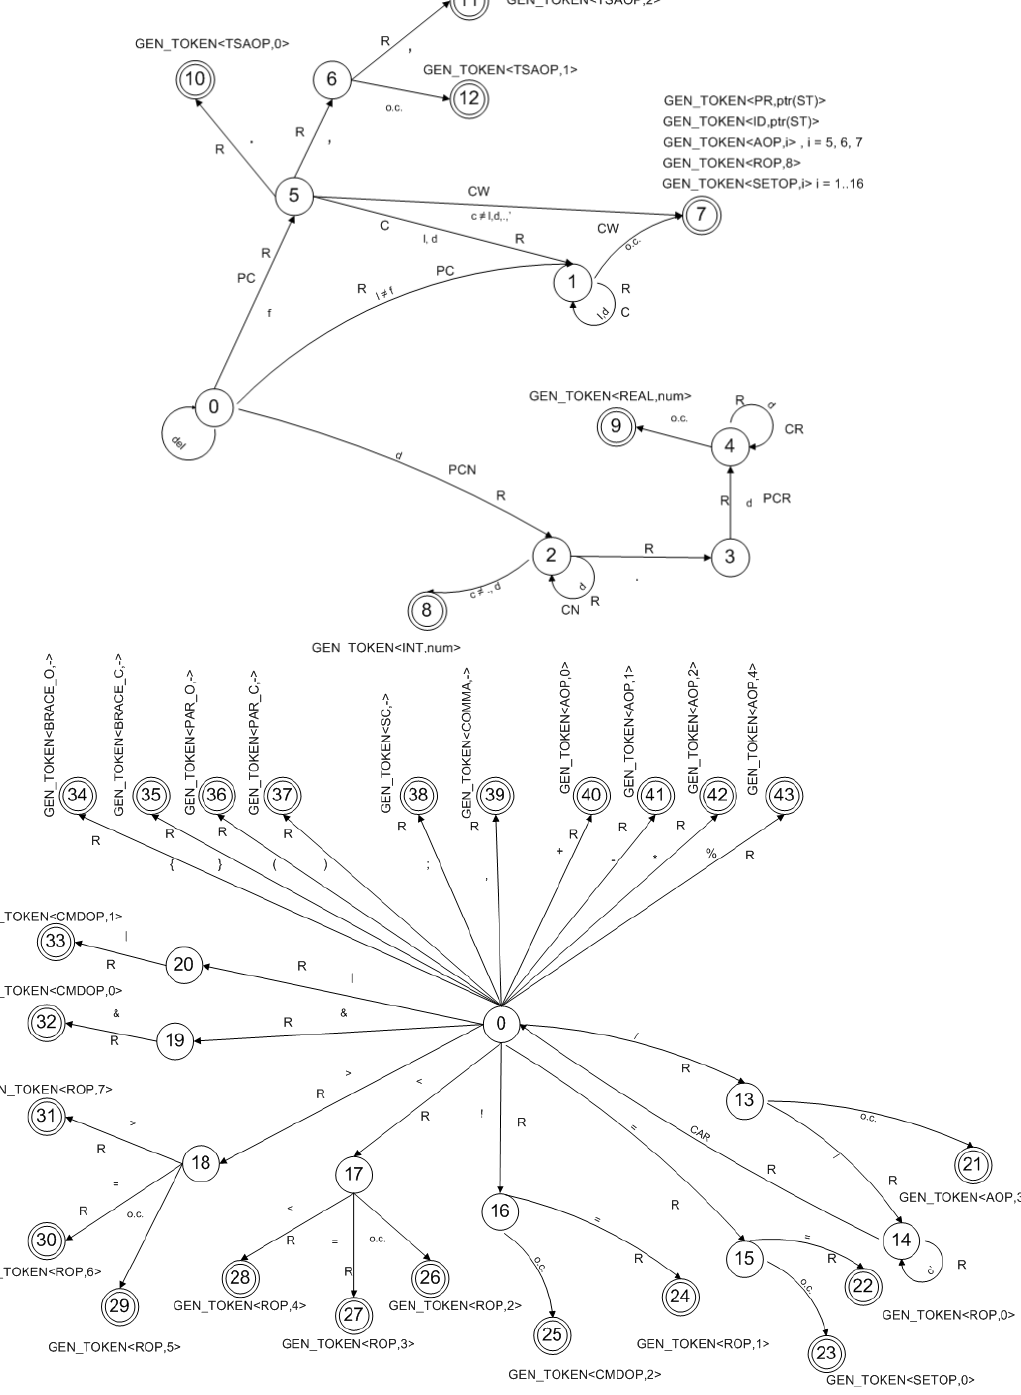
Figure 4. Lexical Analyser